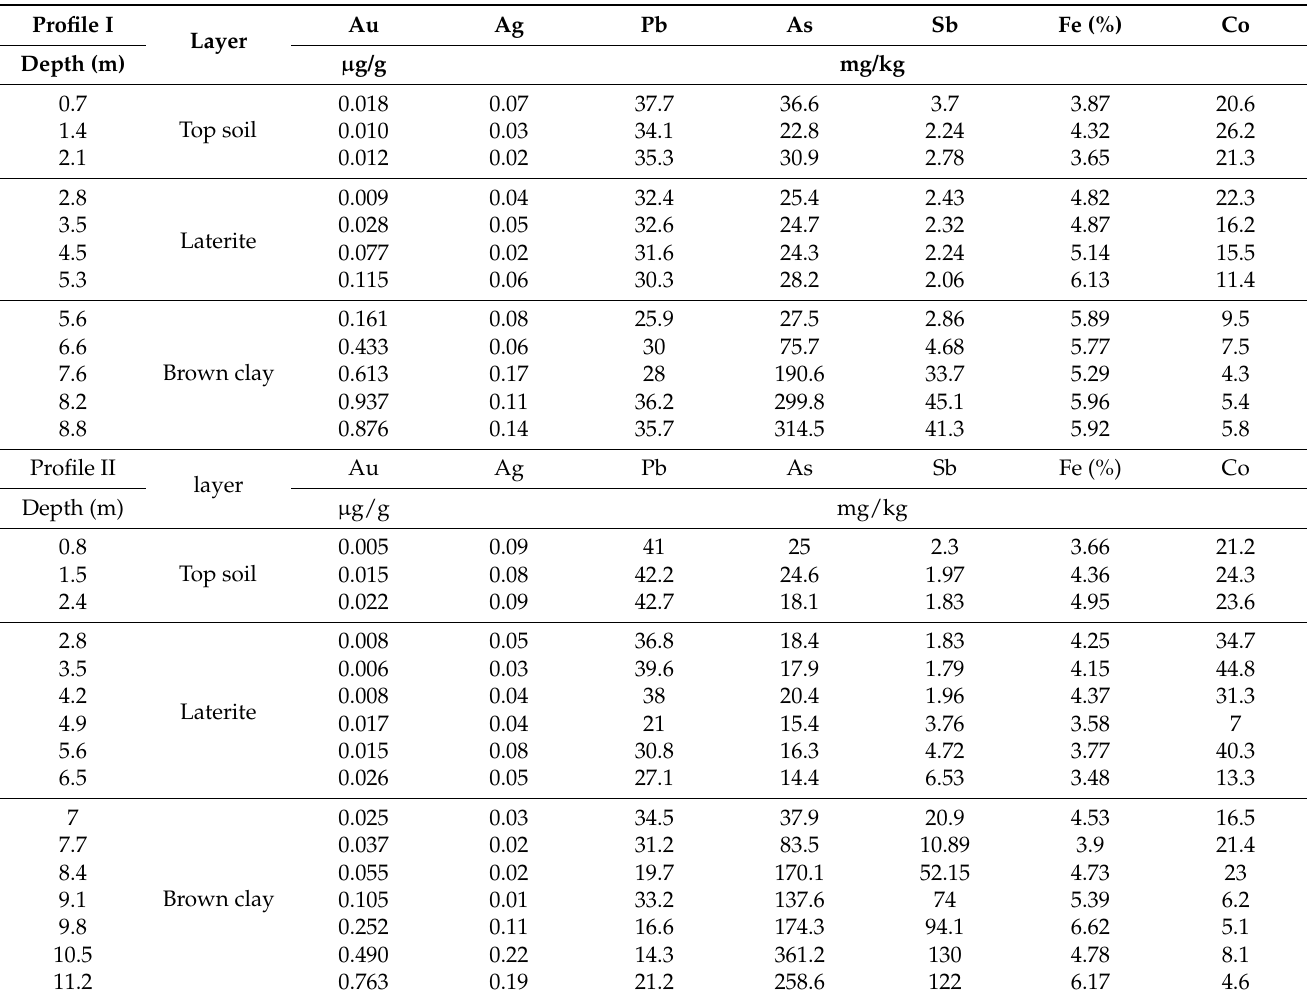
Table 1. The elements concentration of mine profiles.